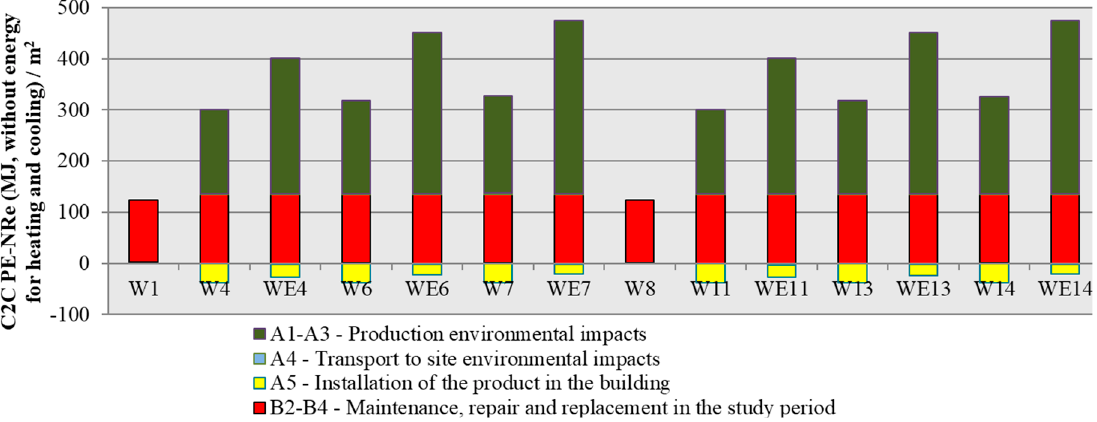
Figure 8. C2C consumption of non-renewable primary energy (PE-NRe, in MJ, without energy for heating and cooling)/m 2 of the external wall alternatives of ETICS with ICB and